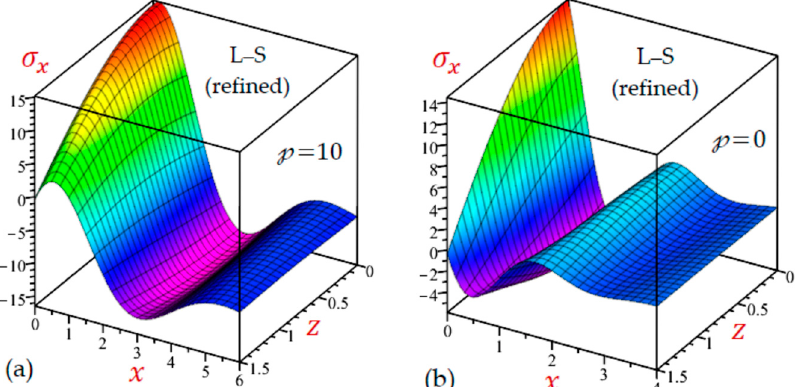
Figure 19. 3D distributions of the transverse displacement w of the rotating half-space: ( a ) with initial pressure ( (cid:112) = 10) and ( b ) without initial pressure ( (cid:112) = 0) using the refined G–L generalized theory.